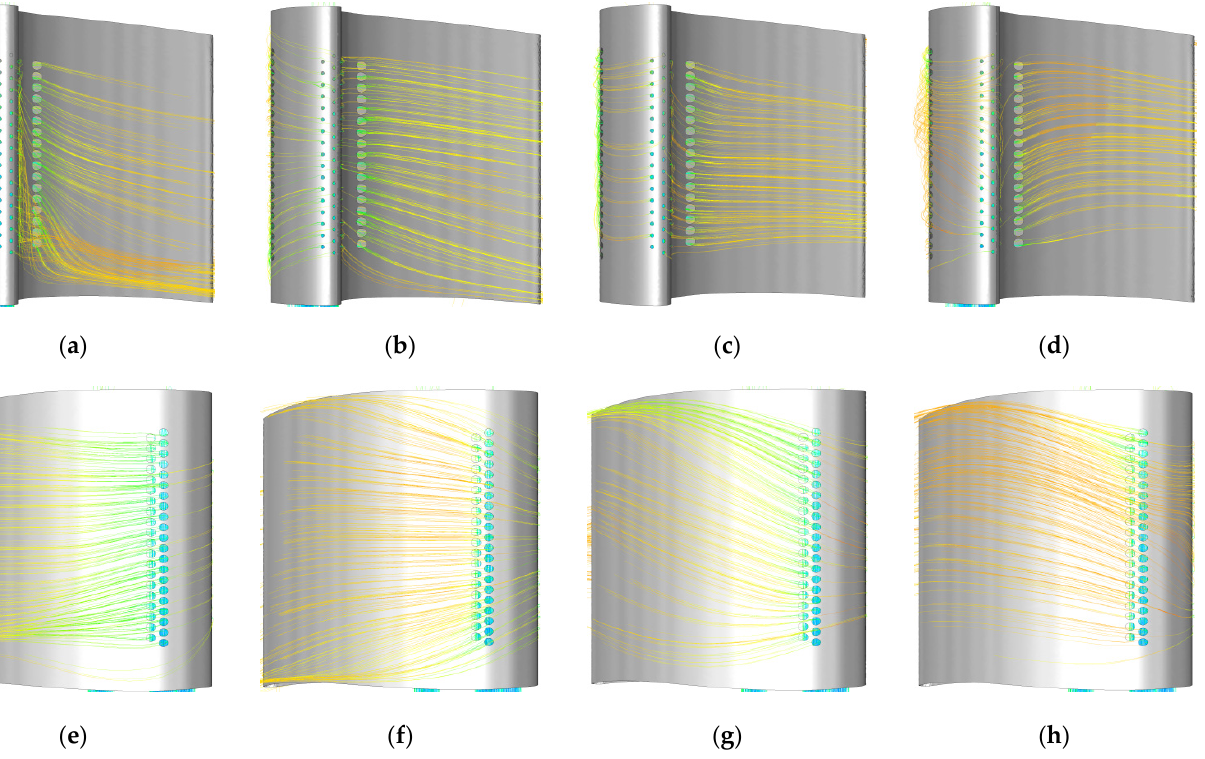
Figure 10. The streamlined pattern of the film cooling air at different relative stator–rotor locations. ( a ) Pressure Side At 0/4 T ; ( b ) Pressure Side At 1/4 T ; ( c ) Pressure Side At 2/4 T ; ( d ) Pressure Side At 3/4 T ; ( e ) Suction Side At 0/4 T ; ( f ) Suction Side At 1/4 T ; ( g ) Suction Side At 2/4 T ; ( h ) Suction Side At 3/4 T .